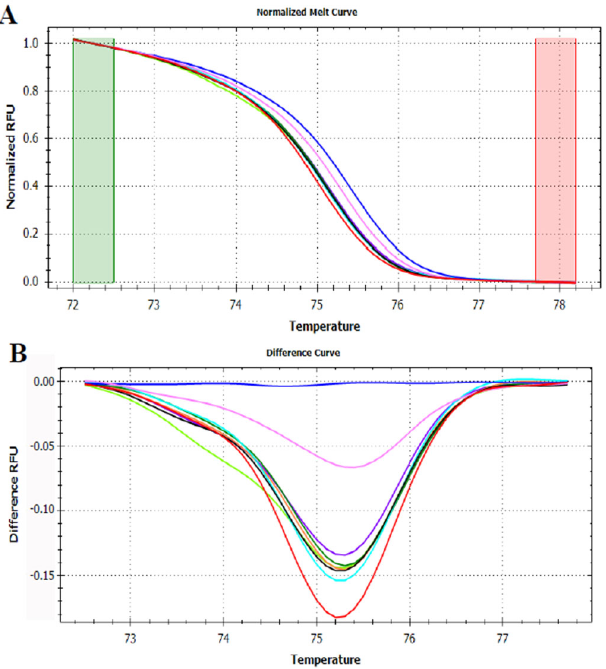
Figure 8. Normalized melt curve ( A ) and difference curve ( B ) of HRMA of P6 loop of trnL (UAA) intron on DNA blends of apple and pear. Apple fruit: red, pear fruit: pink, apple/pear DNA mixes 99.5%/0.5%: black, 99%/1%: light blue, 95%/5%: green, 90%/10%: orange, 75%/25%: purple and 50%/50%: light green. Reference cluster is peach fruit: blue. The HRMA has been carried out on three independent replicates of each sample and the most representative curve of each sample is reported in the graph.